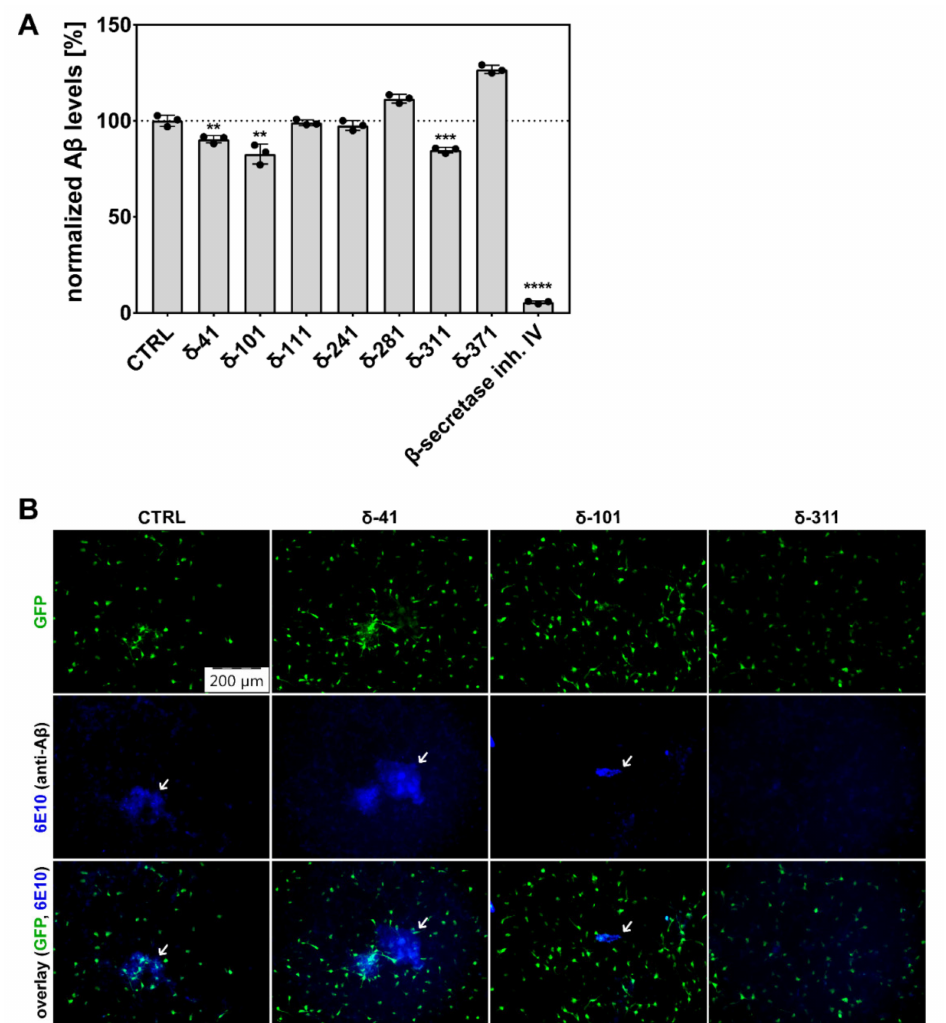
Figure 5. Generation of A β and formation of amyloid plaques was reduced by treatment with CK1 δ -derived peptides. ( A ) Thick-layer 3D cultures of transduced and differentiated hNPCs were treated with DMSO (CTRL), 1 µ M of the indicated CK1 δ -derived peptides, or 10 µ M of β -secretase inhibitor IV for six weeks. Levels of A β in conditioned media were determined by ELISA. Results were normalized towards A β levels detected for control cells. Statistical analysis was performed using one-tailed t -test shown as ** for p ≤ 0.01, *** for p ≤ 0.001, or **** for p ≤ 0.0001. ( B ) Thin-layer 3D cultures of transduced and differentiated hNPCs were fixed and stained after being treated with DMSO (CTRL) or 1 µ M of the indicated CK1 δ -derived peptides for six weeks. GFP fluorescence results from transduction with the lentiviral construct coding for mutant APP695 (Swedish and London mutation) and GFP. Amyloid plaques were stained using an A β -specific antibody. Images were taken at 10 × magnification using an epifluorescence microscope (Olympus IX81) ( n = 3). Scale bar: 200 µ